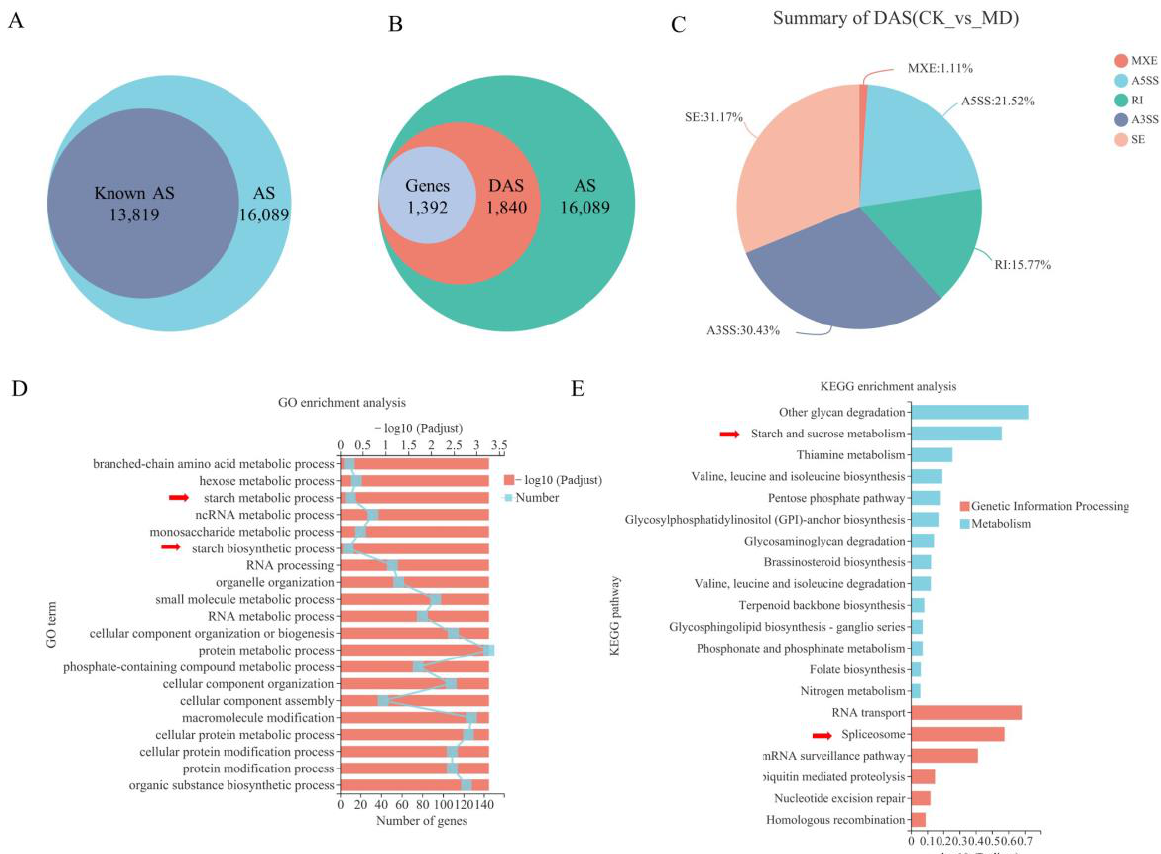
Figure 2. Identification of DAS events and most enriched GO and KEGG pathways of DAS genes in inferior kernels in the comparison of CK and MD at 9 DAA. ( A ) Proportion of known AS in all AS events; ( B ) Proportion of DAS in all AS events; ( C ) Summary of DAS type, represented as percentages; ( D ) The top 20 most enriched GO pathways of DAS genes; ( E ) The top 20 most enriched KEGG pathways of DAS genes. Several prominent signaling pathways were annotated with red arrow.